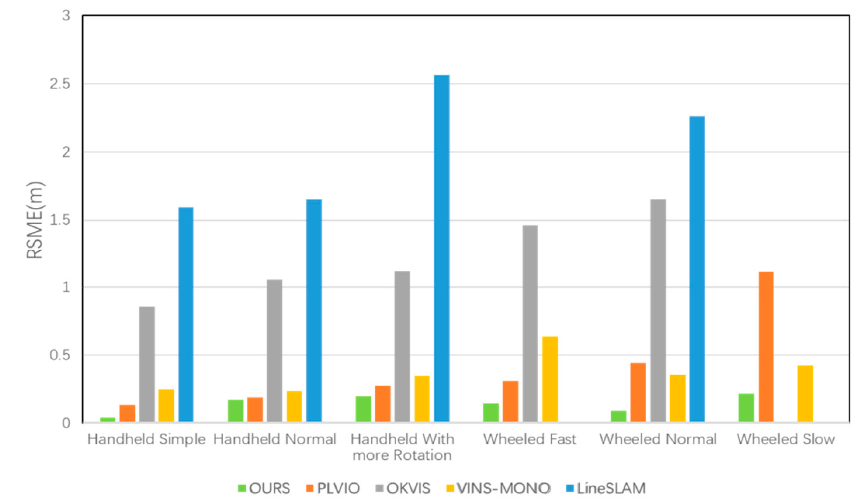
Figure8. Figure 8. The RSME for OURS, PLVIO, OKVIS, VINS-MONO and LineSLAM in the STAR-Center dataset.